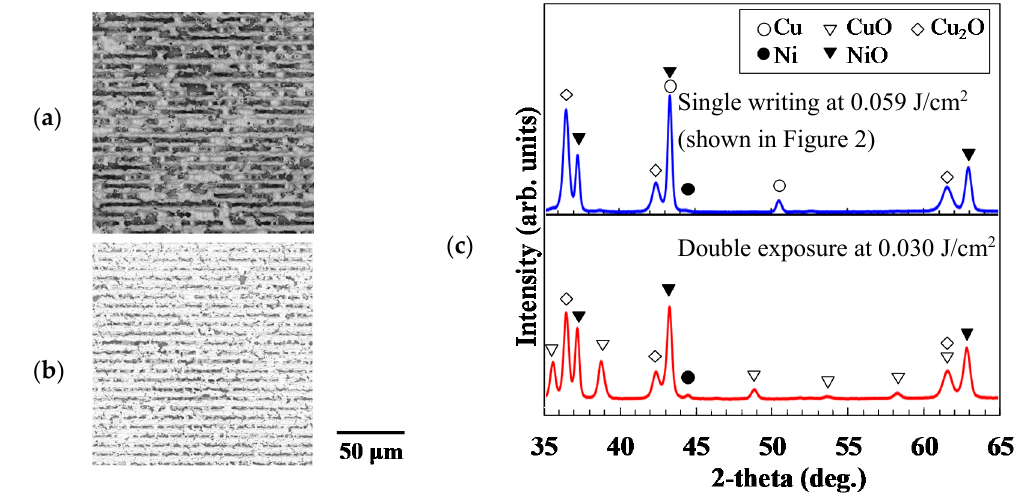
Figure 6. SEM images of the surfaces of micropatterns fabricated with ( a ) single exposure at 0.059 J/cm 2 and ( b ) double exposure at 0.030 J/cm 2 ; ( c ) XRD spectra of the micropatterns.